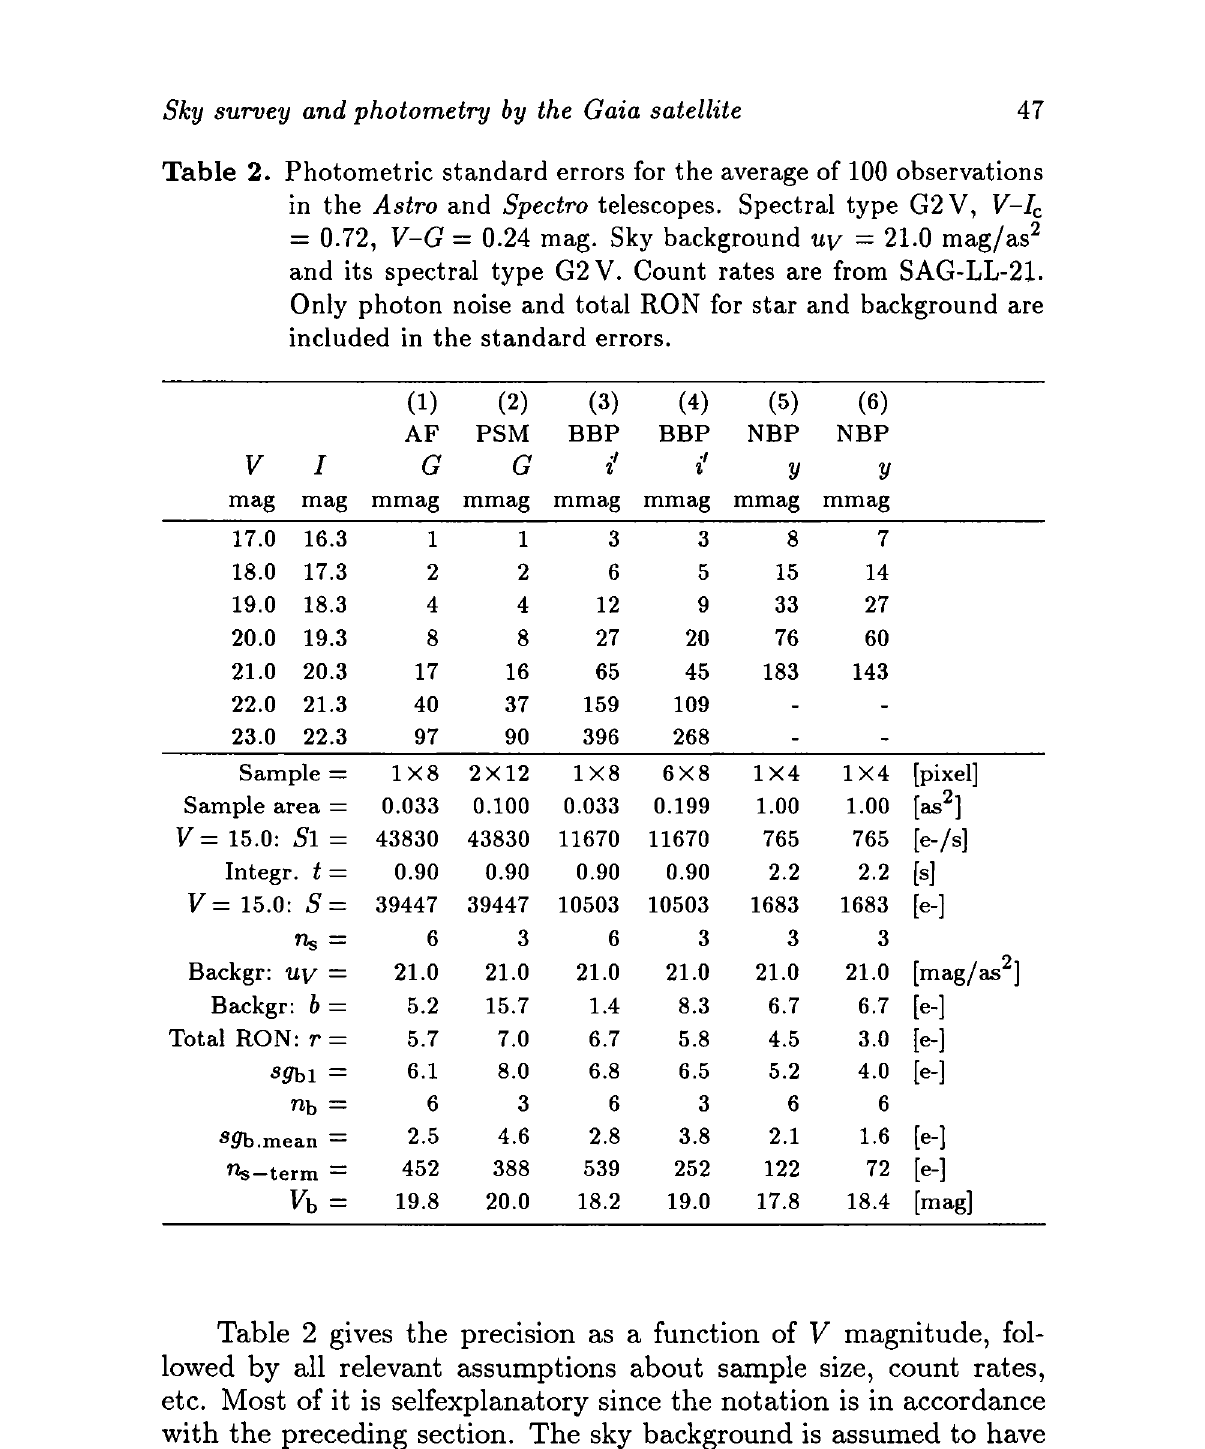
Table 2. Photometric standard errors for the average of 100 observations in the Astro and Spectro telescopes. Spectral type G2V, V-I c = 0.72, V-G = 0.24 mag. Sky background uy = 21.0 mag/as 2 and its spectral type G2V. Count rates are from